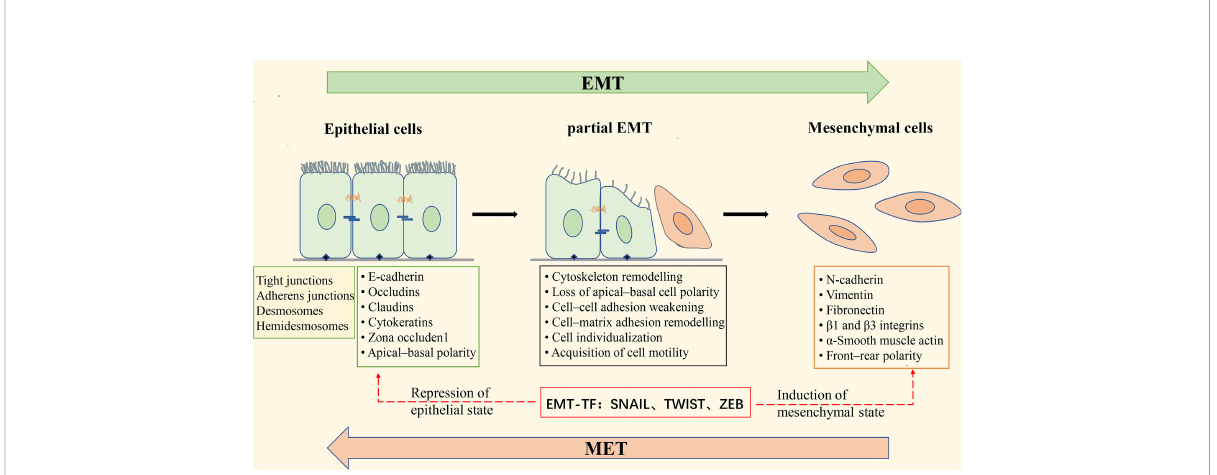
FIGURE 2 Schematic diagram of epithelial-mesenchymal transformation. Apical-basal polar epithelial cells are attached by tight junctions, gap junctions, desmosome, and adhesion junctions, and to the basement membrane by Hemidesmosome; epithelial cells express epithelial cell markers such as E-cadherin, Occludins, Claudins, and Cytokeratins. Induction of epithelial-mesenchymal transition (EMT) leads to the expression of the EMT transcription factors (EMT-TF) ZeB, Snail, and Twist, which repress the expression of epithelial cell-associated genes and simultaneously activate the expression of mesenchymal cell-associated genes. These changes in gene expression result in morphological alterations of epithelial cells, deconstruction of intercellular junctions, the acquisition of front-rear polarity, and the ability of cells to become motile and invasive. During the transition from epithelial to mesenchymal cells, the cells undergo a “ partial EMT ” state, in which the cells are intermediate between a fully epithelial and fully mesenchymal state, retaining both epithelial and mesenchymal characteristics. EMT is reversible, and the process of mesenchymal-epithelial transformation (MET) allows the cells that have undergone EMT to return to the epithelial